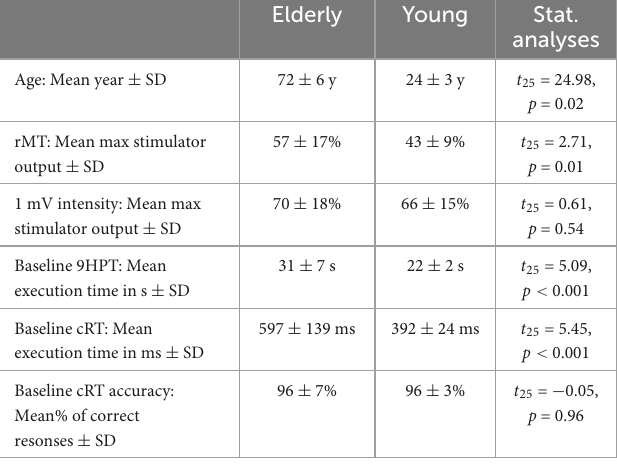
TABLE 1 Demographic information, neurophysiological parameters and motor performance of the two groups at Baseline. Elderly Young Stat.